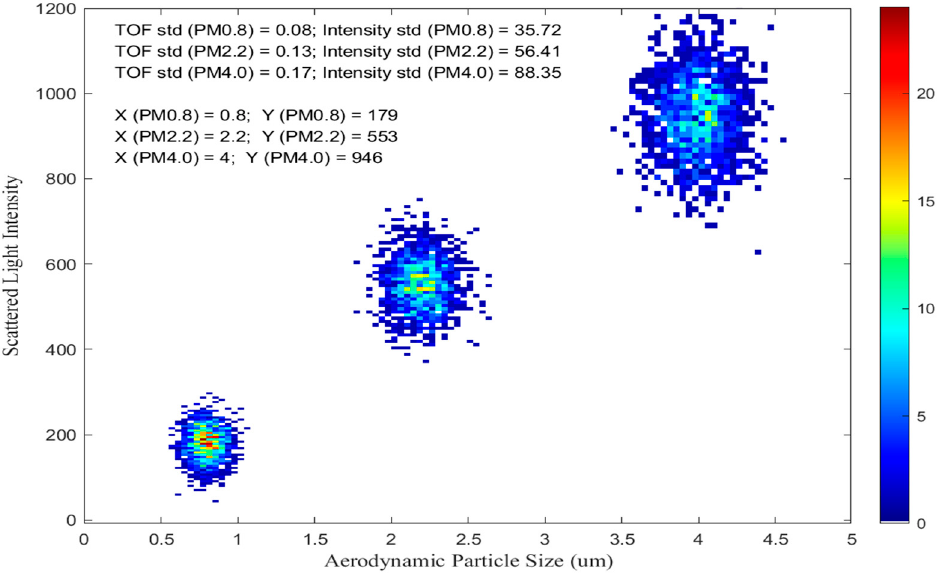
Figure 10. Sca tt ered Light Intensity of PM0.8\PM2.2\PM4. Figure 10. Scattered Light Intensity of PM0.8 \ PM2.2 \